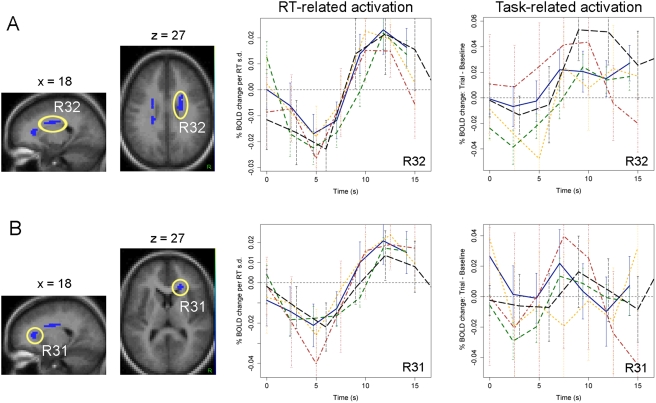
Time courses of RT-related activation in representative white matter ROIs.